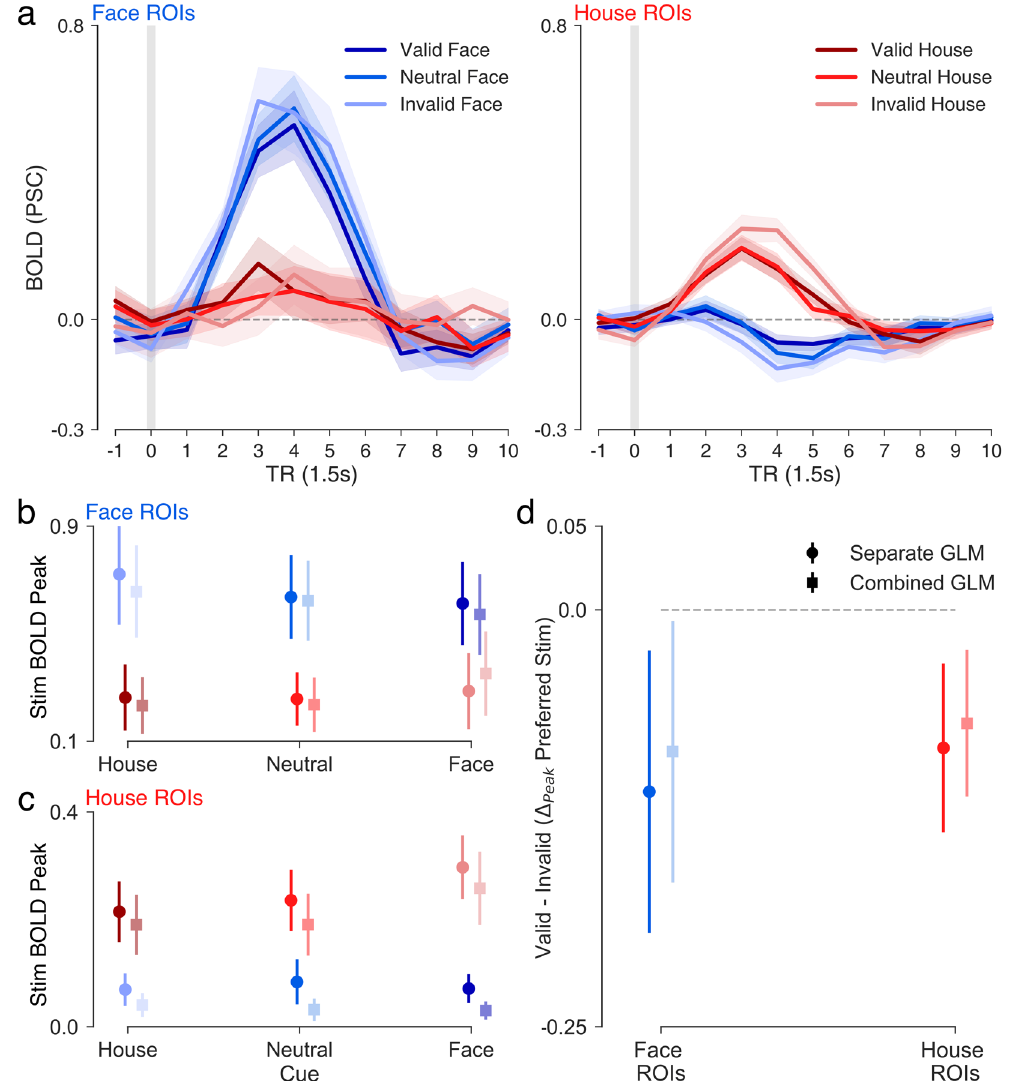
Figure 5. Effects of expectations on stimulus-phase activity. ( a ) Timecourse of activity (12 × 1.5 s) in face (blue, left) and house (red, right) ROIs time-locked to 1 TR before stimulus onset estimated from full trials in the separate events GLM. ( b ) Peak face-evoked activity in face-selective ROIs across cue types based on the separate events GLM (circle markers; darker shades) and combined events GLM (square markers; lighter shades). ( c ) Peak house-evoked activity in house-selective regions with same plotting conventions as in b. ( d ) Peak difference in stimulus-evoked activity following valid versus invalid expectations in face (e.g., left; blue error bars) and house (e.g., right; red error bars) ROIs. Negative values imply suppression of stimulus-evoked activity when cued expectations are valid. Shaded area around mean timecourses reflect + / − 1 s.e.m. Error bars in point plots reflect 95% c.i. around the